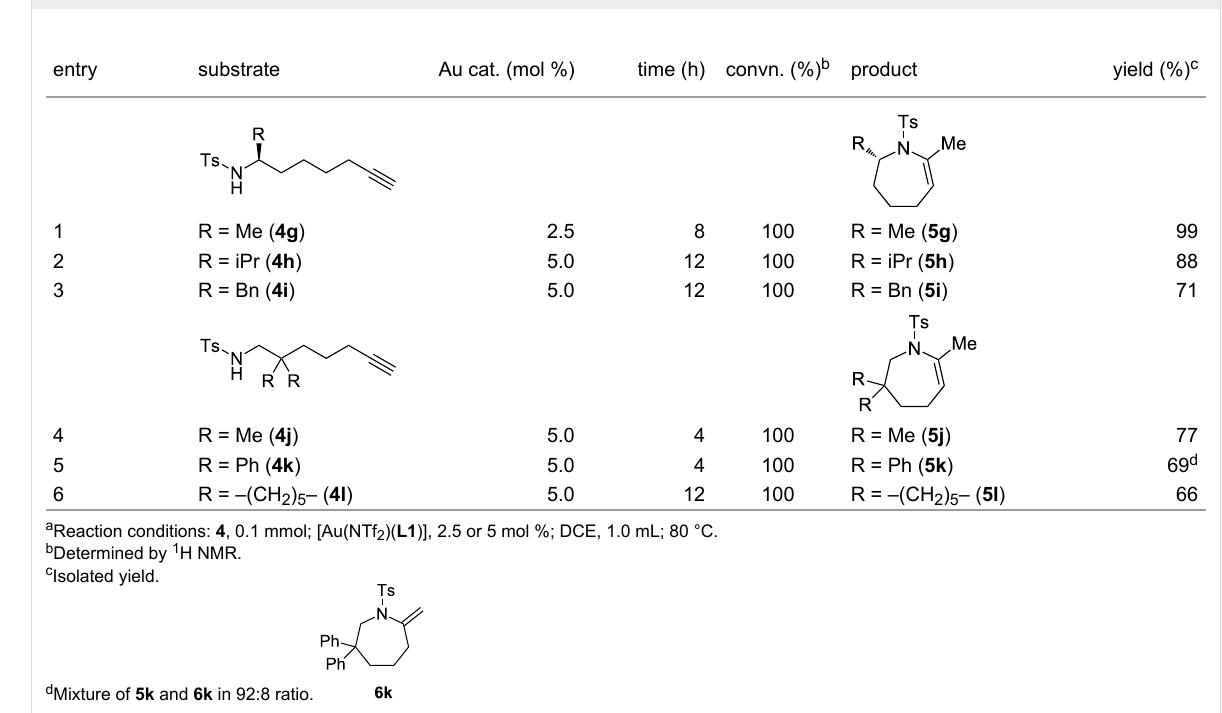
Table 3: Cyclization of alkynic sulfonamides with an acyclic linker.